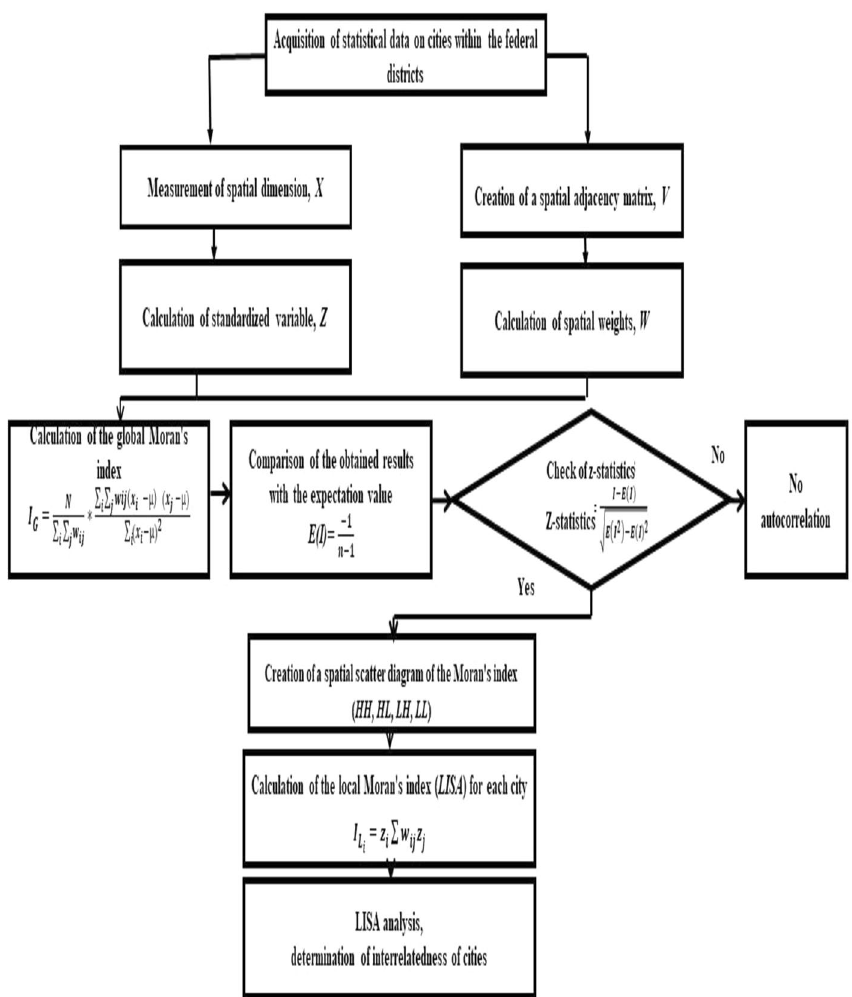
Fig. 1 Algorithm for evaluation of spatial interrelatedness of Russian